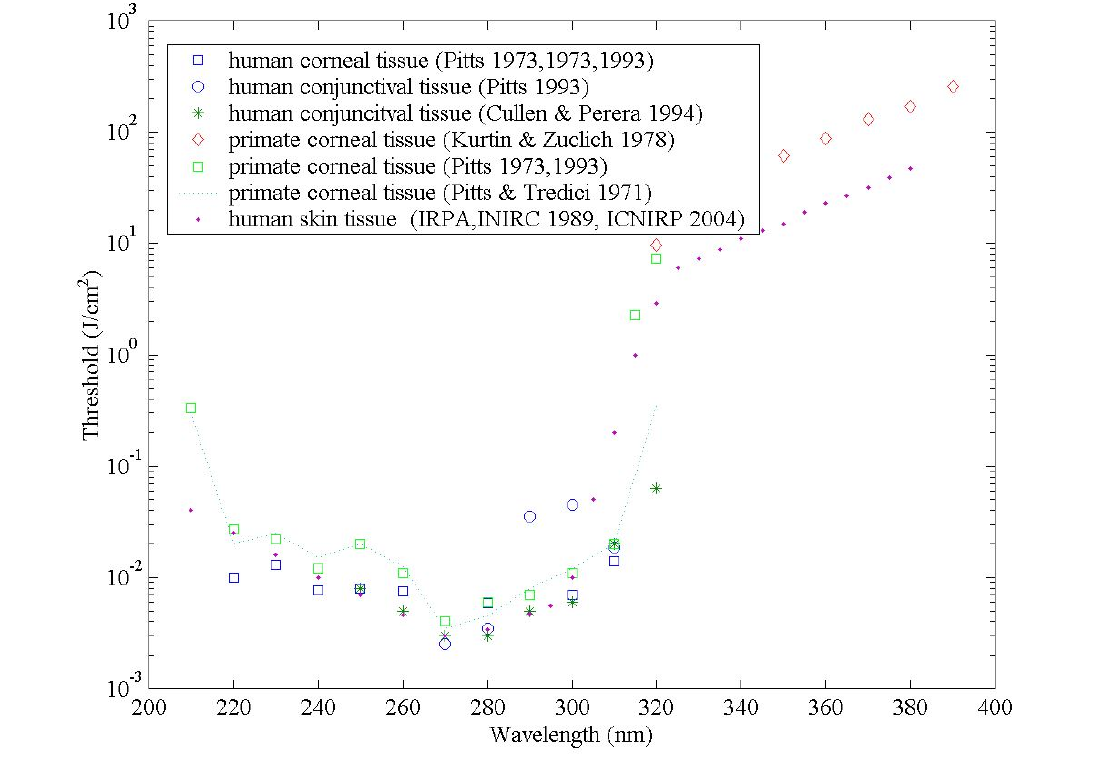
Figure 1. Published corneal, conjunctival and skin UVR threshold